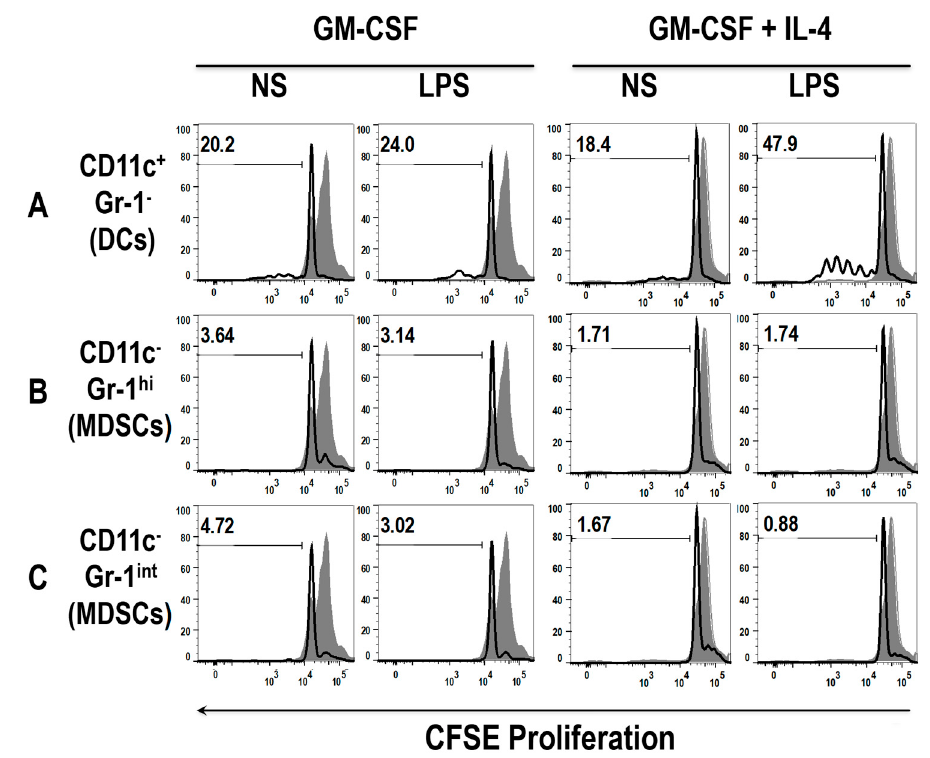
Figure 7. Early DCs, but not MDSCs, from both GM-CSF and GM-CSF + IL-4 cultures, induce T cell proliferation following LPS stimulation. Cells from day 4 GM-CSF derived BM cultures were sorted with a FACS Aria cell sorter into ( A ) DCs, ( B ) Gr-1 hi MDSCs and ( C ) Gr-1 int MDSCs. These cells were either un-stimulated or pre-stimulated with LPS for 24 h before incubation with T cells for 3 days at a ratio of 1:30 (DC: T cells). T cell proliferation was measured by CFSE. The shaded grey area represents the CFSE positive control. Numbers within the histograms depict percentage of cells proliferated. Histograms are representative of three mice.